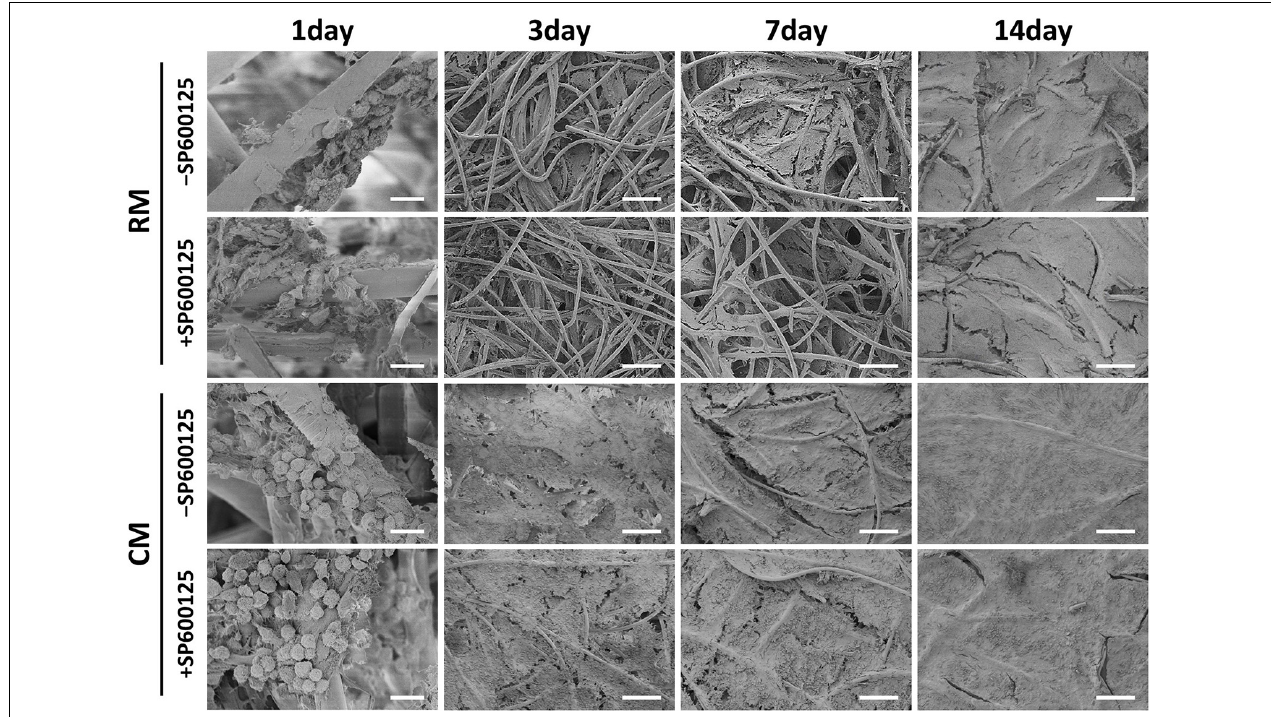
FIGURE 4 | ECM production by auricular chondrocytes on PGA/PLA scaffolds observed using SEM. Chondrocytes on scaffolds were separated and displayed round shapes within 24 h. In the following culture period, the ECM deposition increased with time. Treatment with CM enhanced the ECM deposition, while treatment with SP600125 alone decreased it. However, the CM + SP600125 group showed that adding CM reversed this inhibitory effect of SP600125 alone and produced more ECM deposition. Scale bars (1 day) = 20 µ m. Scale bars (3, 7, and 14 days) = 200 µ m. ECM, extracellular matrix; PGA, polyglycolic acid; PLA, polylactic acid; RM, regular medium; and CM, chondrogenic